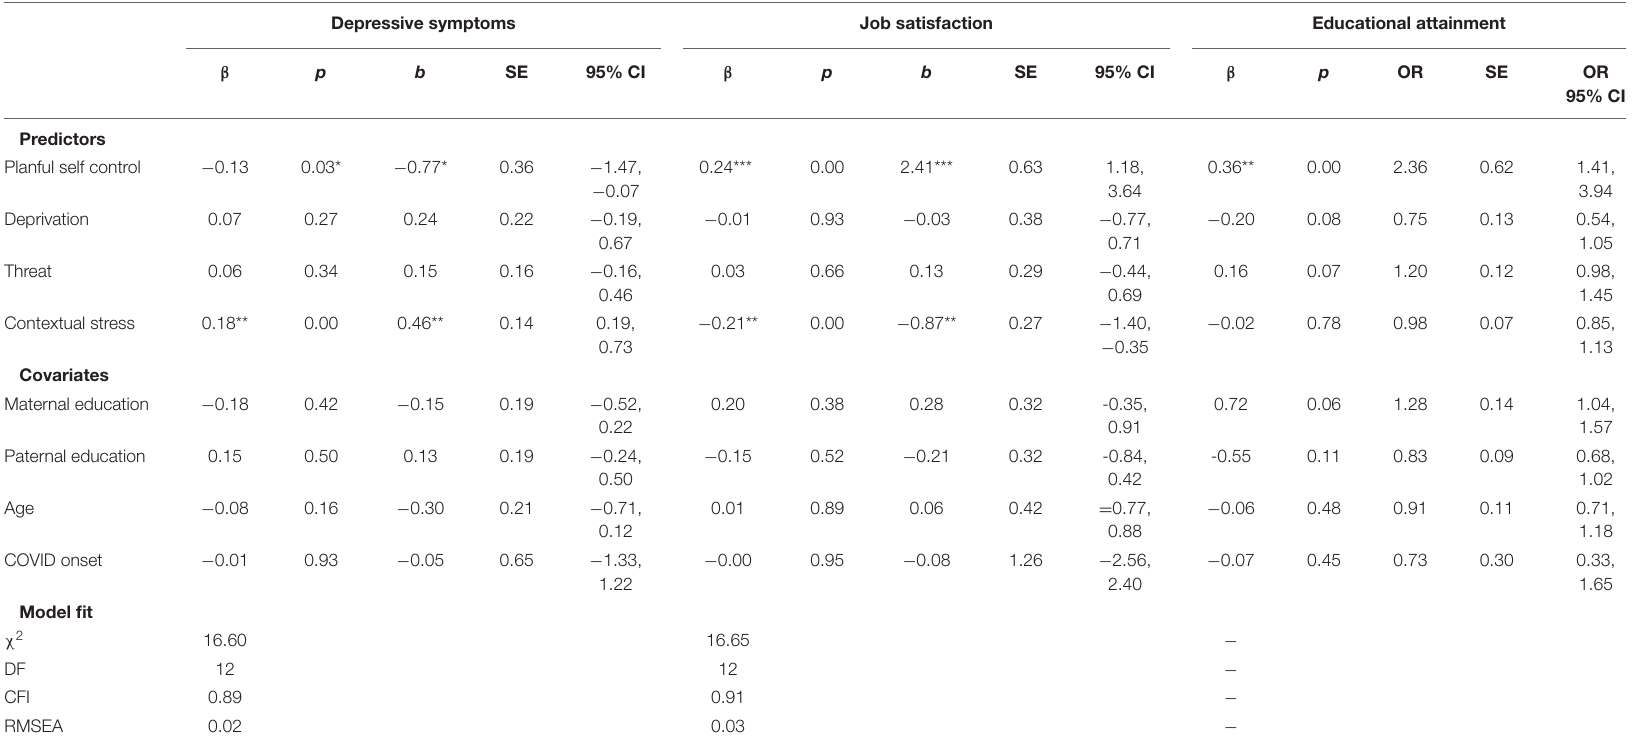
TABLE 2 | Effects of planful self-control, childhood threat, deprivation, and contextual stress on psychosocial outcomes. Depressive symptoms Job